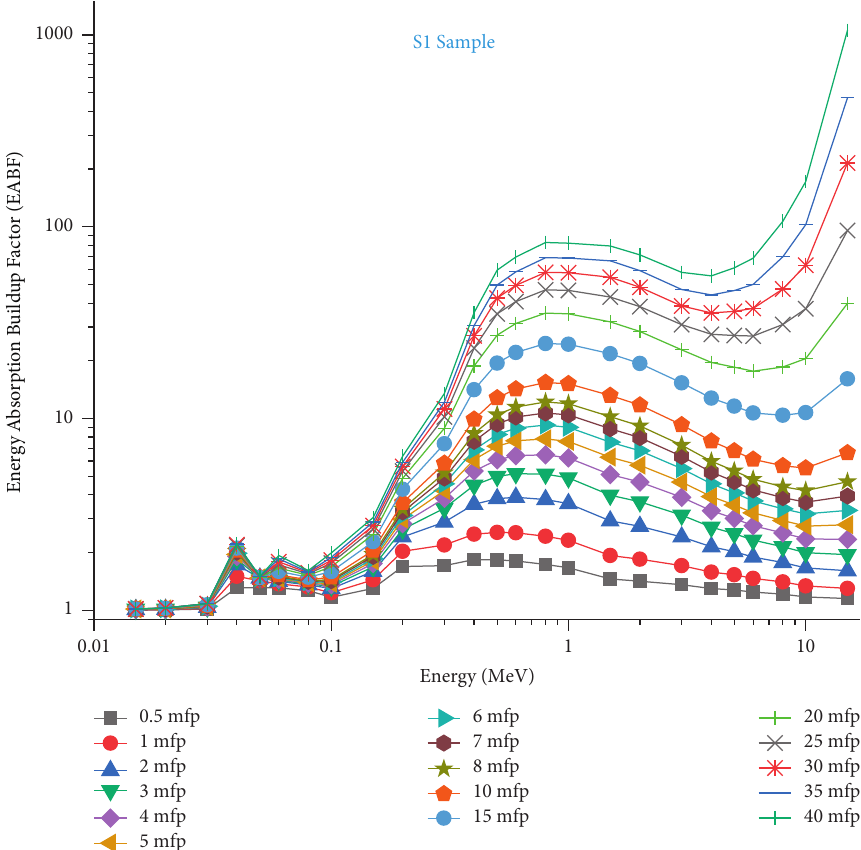
Figure 11: Demonstrates the relationship between the energy and EABF of the S1